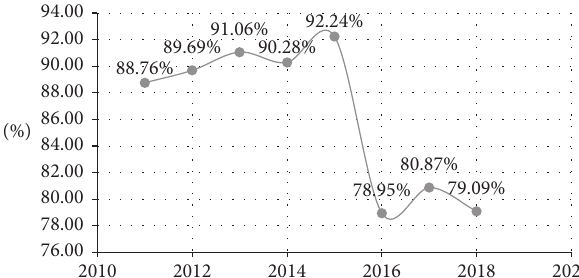
Figure 5: Completion rate of project implementation from 2011 to